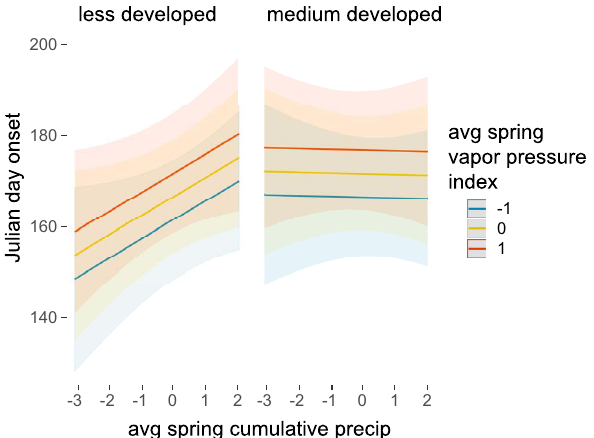
Figure 2. More cumulative precipitation leads to much later onset in less developed regions, but has no impact on phenology in more developed ones. In all cases, higher spring vapor pressure deficit (drier conditions) leads to later onset. Plots were generated using the ‘plot_model’ function in the sjPlot package and functions in ggplot2 package in R.